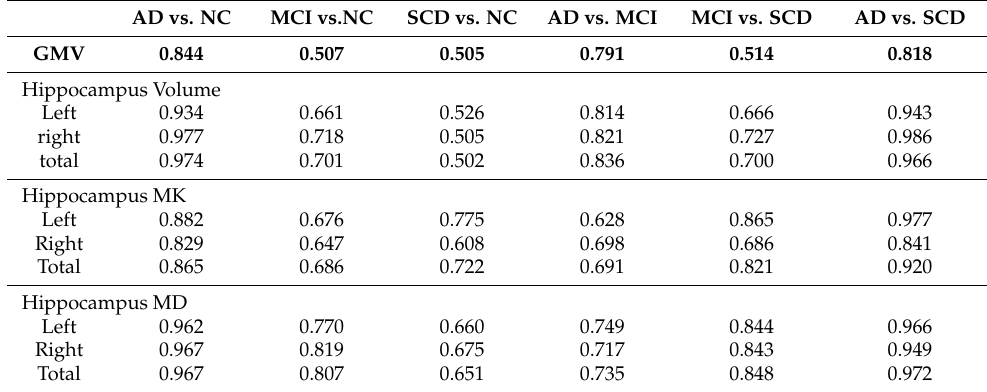
Table 4. AUC values for each pair-wise differential